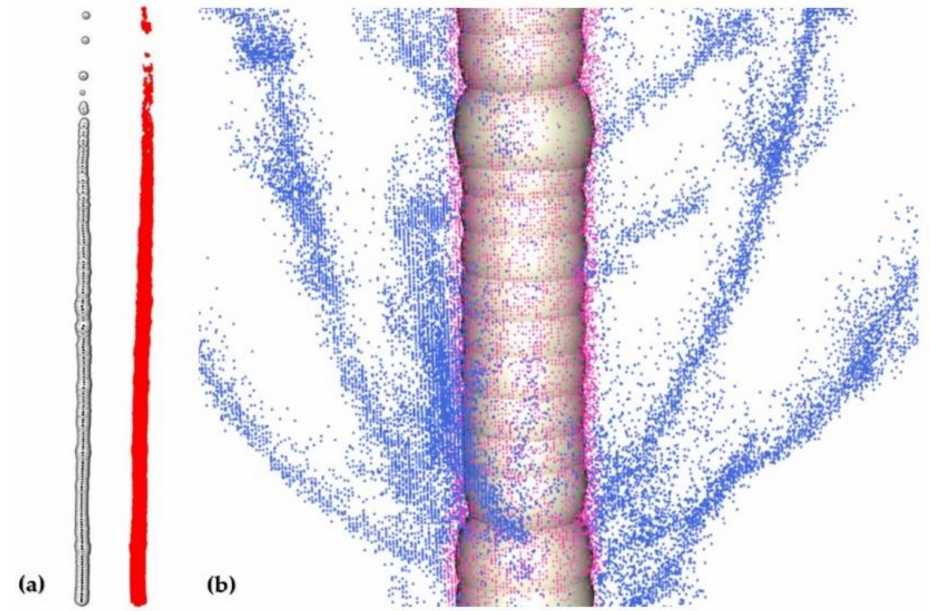
Figure 7. Images showing sphere fitting on a delineated tree stem. ( a ) Spheres of a whole tree stem (left) and stem points (right). ( b ) A close-up showing spheres (off-white), stem points (pink) and branch points